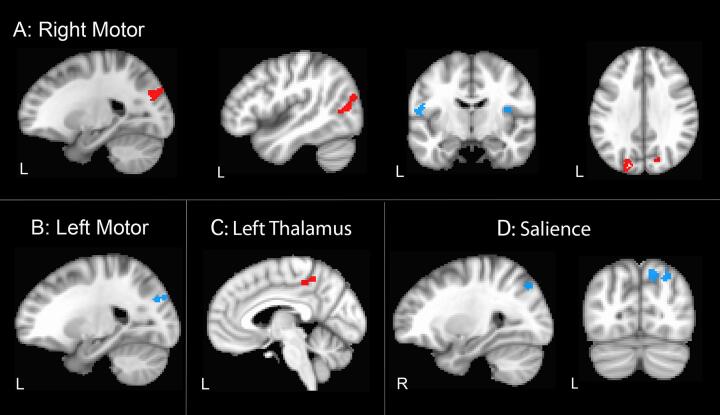
Regions with reduced functional connectivity in C9+ symptomatic C9+ carriers compared to healthy controls. A) Right motor network with five clusters (labeled CS2-6 in Table 3) B) Left motor network with 1 cluster (CS1), C. Left thalamus network with 1 cluster (CS9). D. Salience network with two clusters (CS7-8). Red indicates threshold p < 0.05 FWE-corrected; blue indicates threshold p < 0.1 FWE corrected. The hemisphere of sagittal slices is labelled L, left, or R, right. Note that the precuneus has reduced functional connectivity in both motor networks and the salience network. (For interpretation of the references to colour in this figure legend, the reader is referred to the web version of this article.)